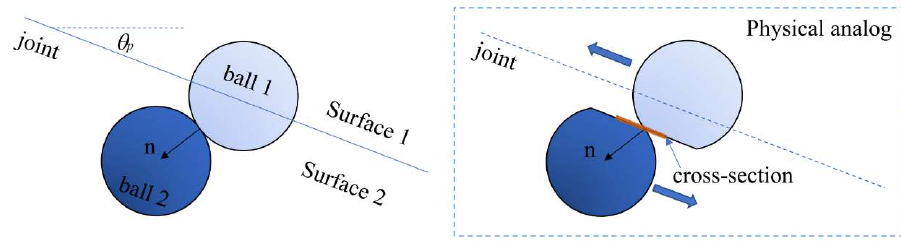
Figure 6. Smooth-joint contact model [51].